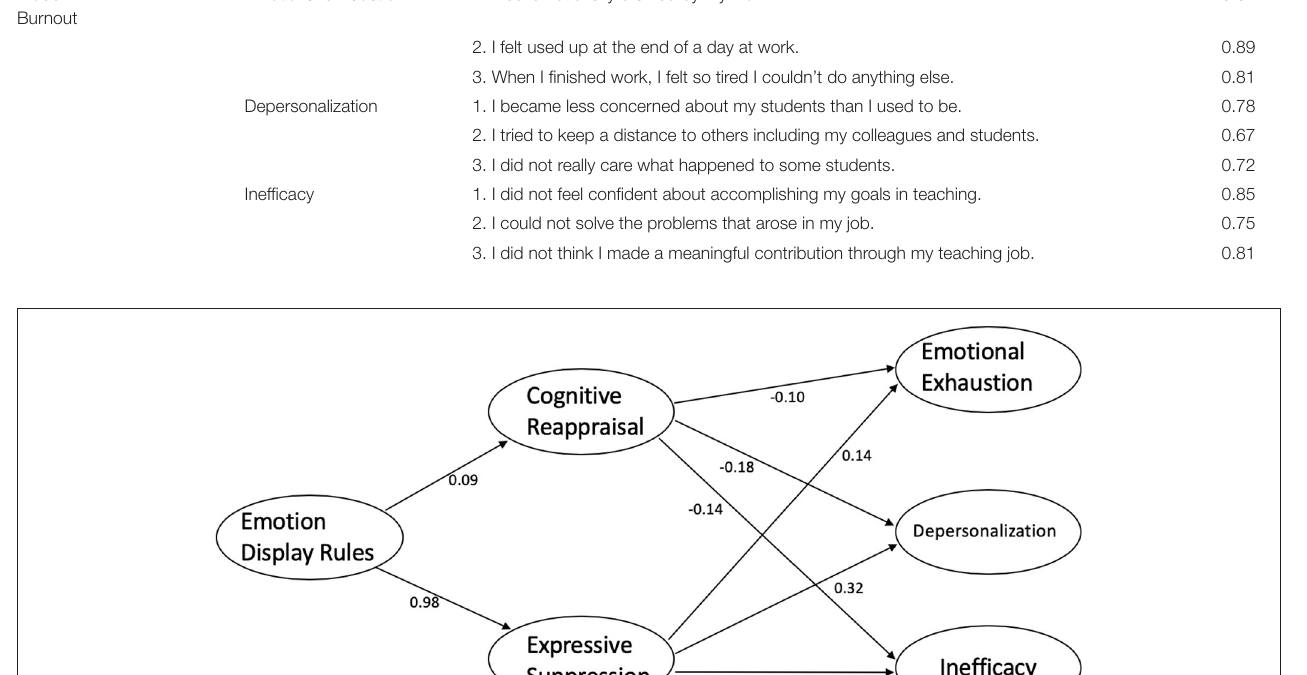
relationship between expressive suppression and emotional exhaustion echoes the results of prior studies on burnout among teachers by Chang (2013), Taxer and Frenzel (2015), and Tsouloupas et al. (2010) and among service workers (Grandey, 2003; Wang et al., 2011). The standardized coefficient ( β = 0.13) was only 0.01 higher than what Tsouloupas et al. (2010) found in their sample ( β =